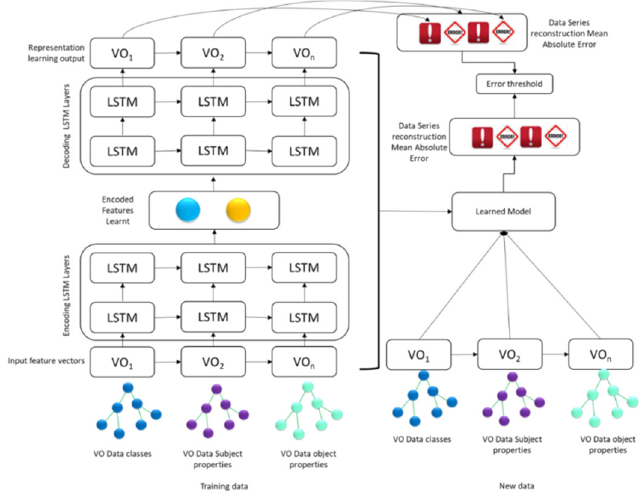
Figure 24. Architecture of designed LSTM-Autoencoder.